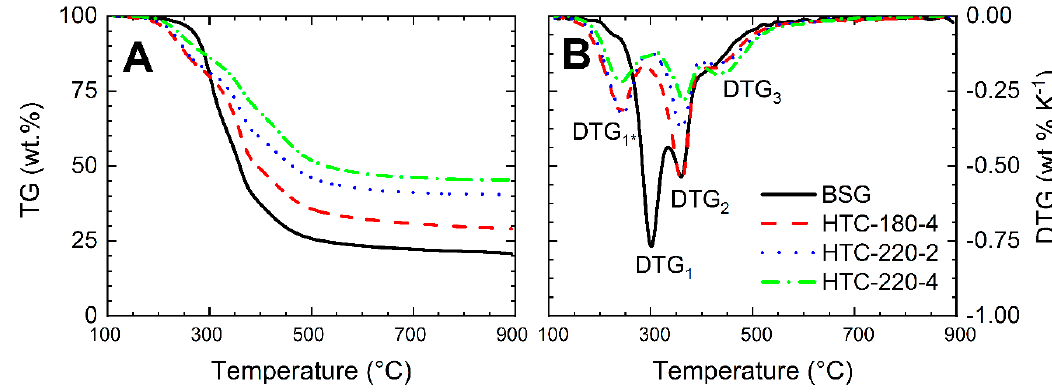
Figure 3. ( A ) TG and ( B ) DTG curves for BSG and hydrochars, heating rate 20 °C min − 1 .